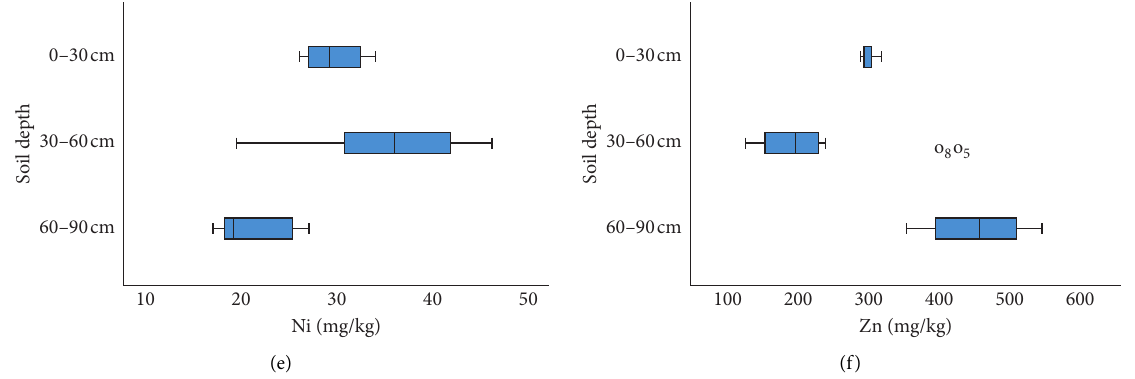
Figure 4: Variation of heavy metal concentration with depth around the